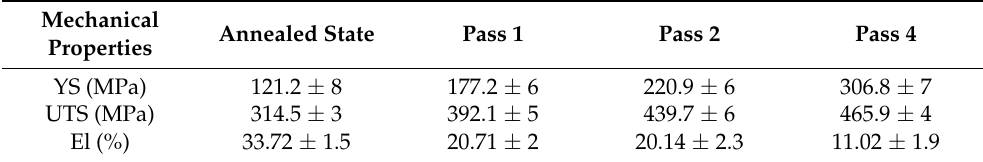
Figure 2. Engineering tensile stress–strain curves for the AA5052 before and after processing with the CEC method with up to four passes at room temperature, as well as the corresponding yield strength (YS), ultimate tensile strength (UTS), and elongation-to-failure (El). Table 1. Mechanical properties of the AA5052, including yield strength (YS), ultimate tensile strength (UTS), and elongation-to-failure (El), before and after processing with CEC method with up to four passes at room temperature.